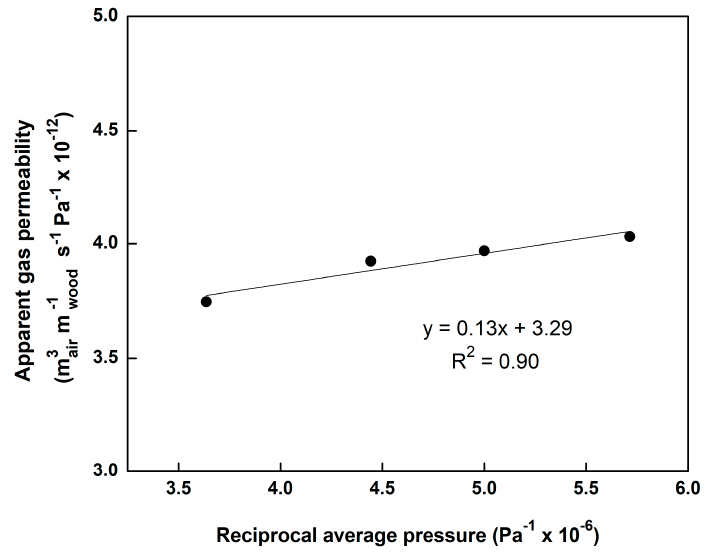
Figure 6. Typical relationship of the apparent gas permeability against the reciprocal average pressure for radial flow of the control